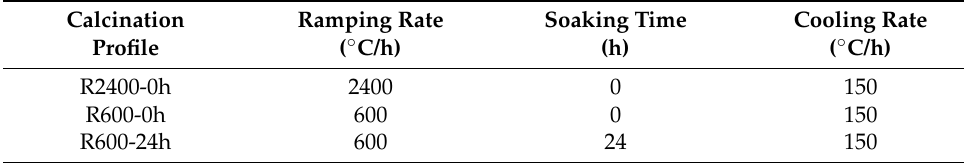
Table 3. Calcination procedure for each